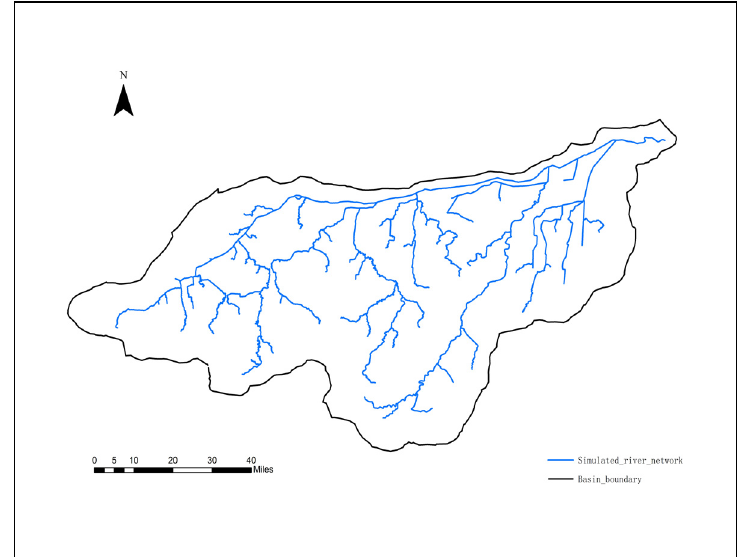
Figure 4. Virtual water system extracted based on WEP.